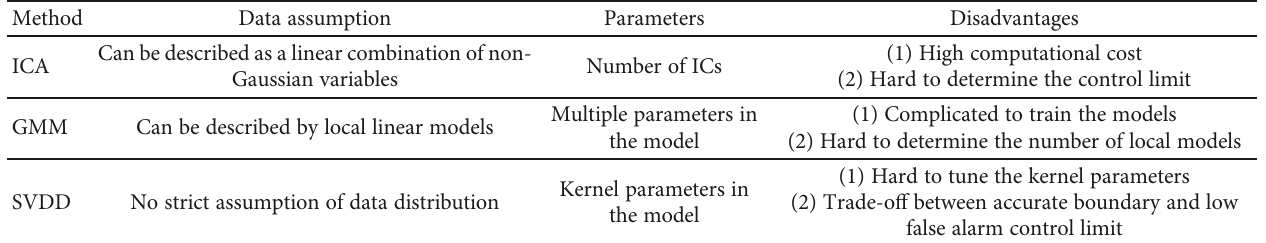
Table 5: Comparisons of the non-Gaussian data